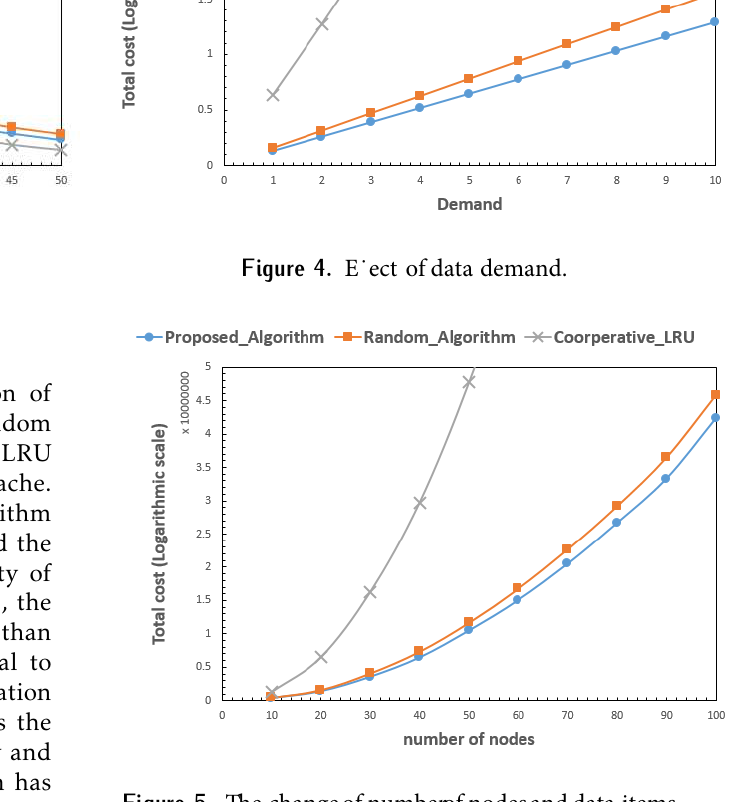
Figure 5. The changeof numberof nodesand data